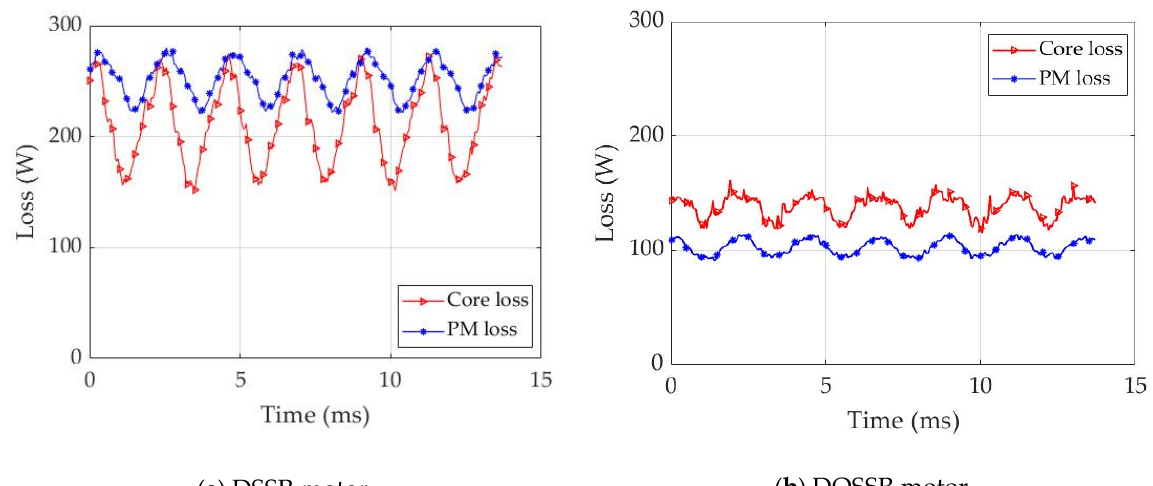
Figure 12. Comparison of core loss and PM loss for the DSSR motor and the DOSSR motor operating at peak torque at base speed (100 A rms, 900 rpm).